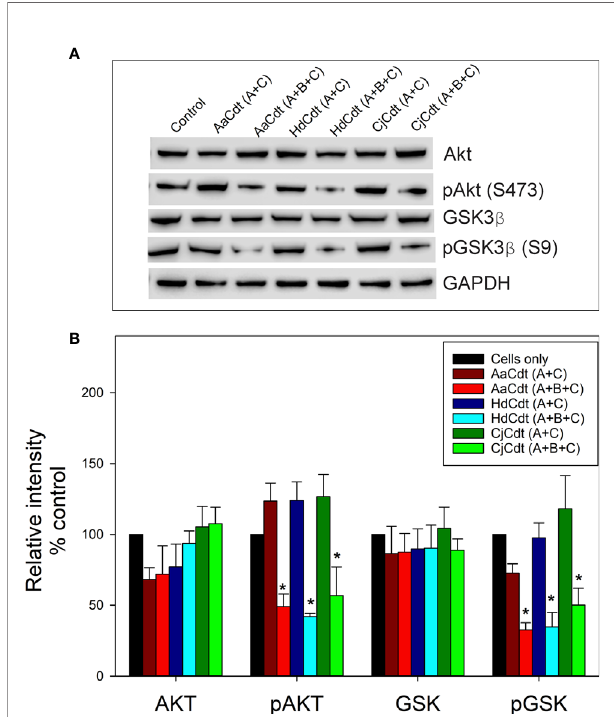
FIGURE 2 | Comparison of the effect of HdCdt and CjCdt with AaCdt on phosphorylation of downstream components of the PI-3K signaling pathway. Jurkat cells were treated with AaCdt (AaCdtA/C: 0.5 nM; AaCdtB: 5.7 nM), HdCdt (HdCdtA/C: 0.2 nM; HdCdtB: 5.7 nM), and CjCdt (CjCdtA/C: 1.0 nM; CdtB: 5.7 nM) for 2 hr and then assessed for levels of Akt, pAkt(S473), GSK3ß and pGSK3ß(S9) by Western blot. (A) shows a representative Western blot; (B) shows the compiled results of four experiments (mean ± SEM); *indicates statistical signi fi cance p < 0.05 when compared to untreated control